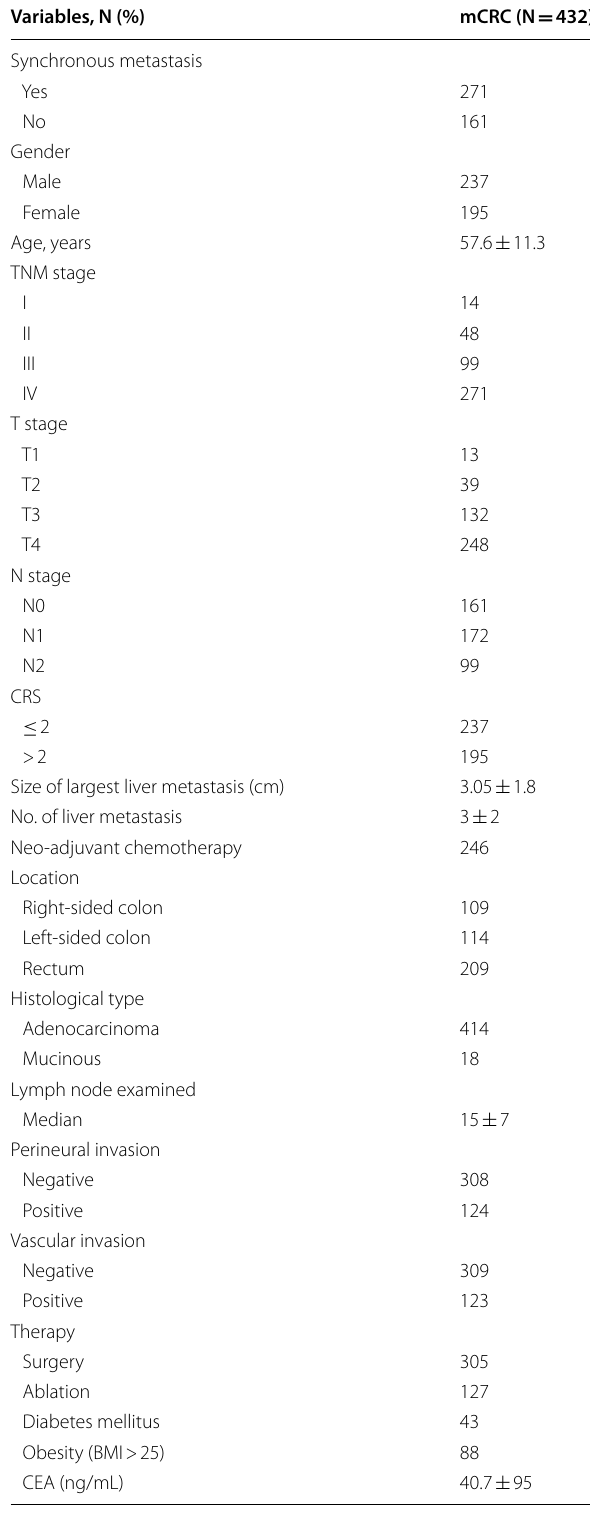
Table 5 Baseline characteristics of the CRC patients with liver